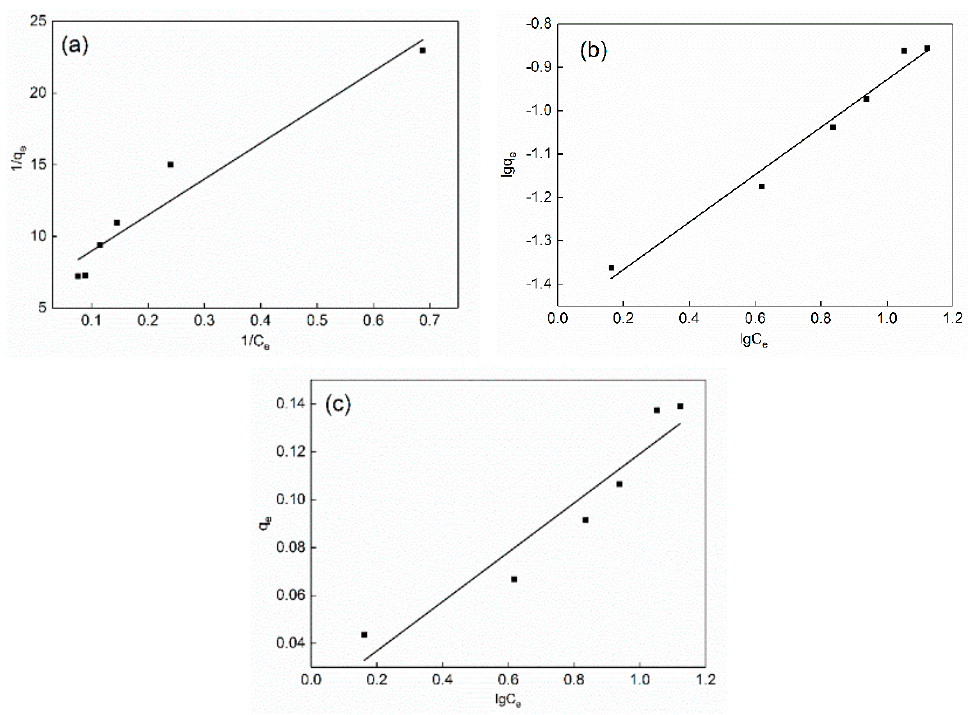
Figure 10. Ferric ion adsorption of ( a ) Langmuir plots, ( b ) Freundlich plots and ( c ) Temkin plots (pH = 8).